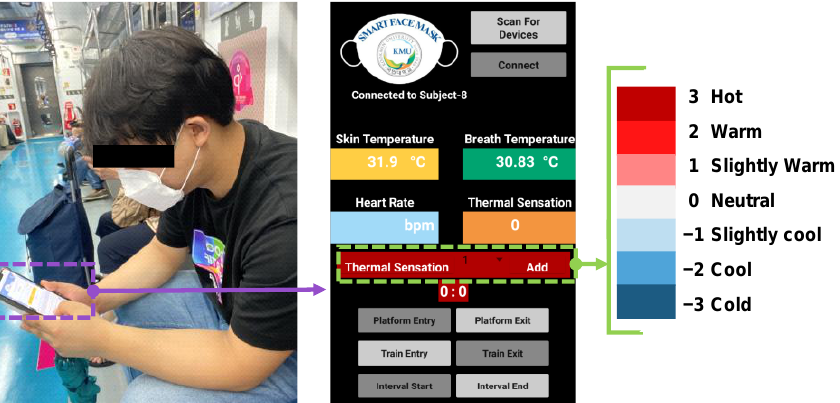
Figure 2. Mobile interface for thermal sensation votes (TSVs), skin temperature (SKT), and exhaled breath temperature (EBT).